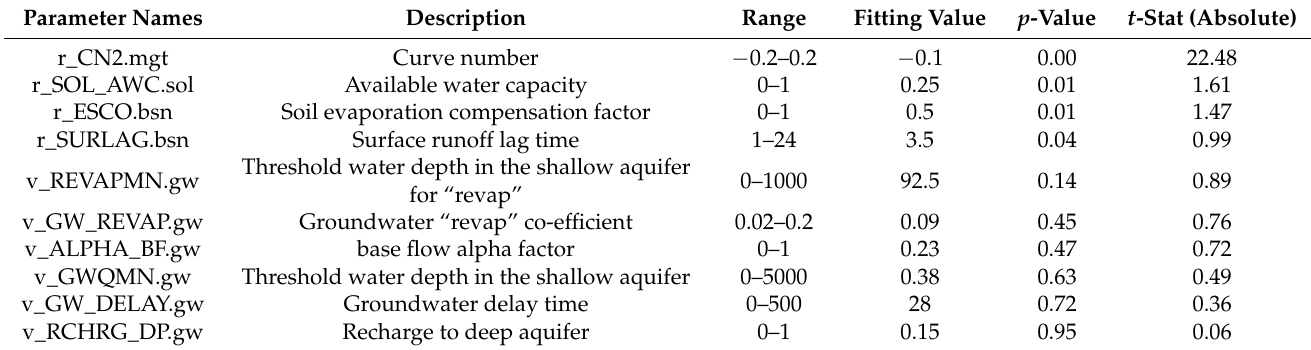
Table 1. Parameters used for sensitivity analysis and calibration of the SWAT